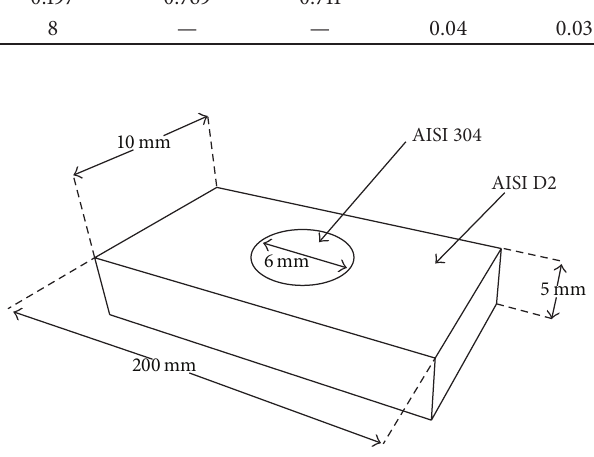
Figure 1: Diagram of the combination of the two different samples.